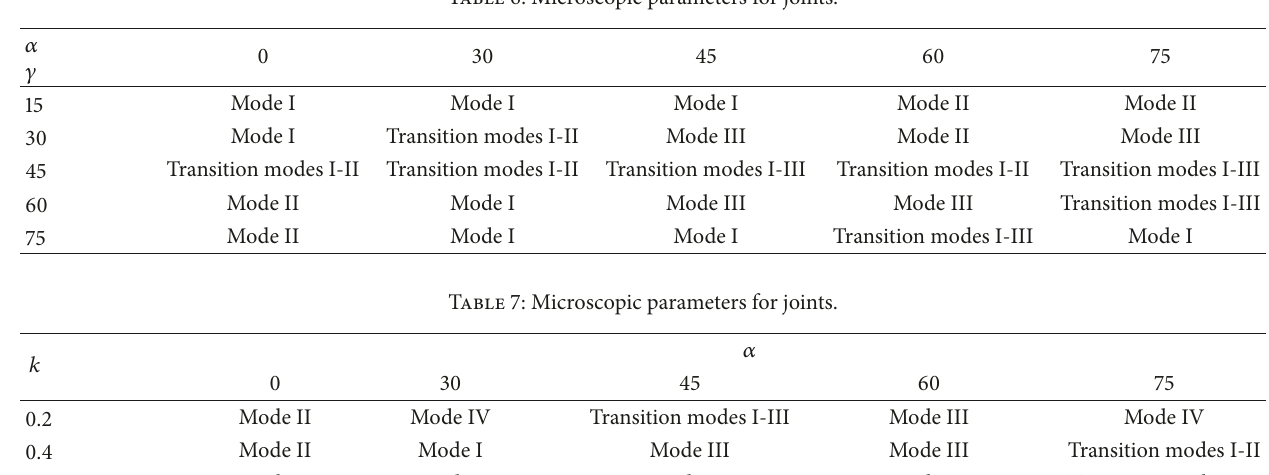
Table 6: Microscopic parameters for joints.